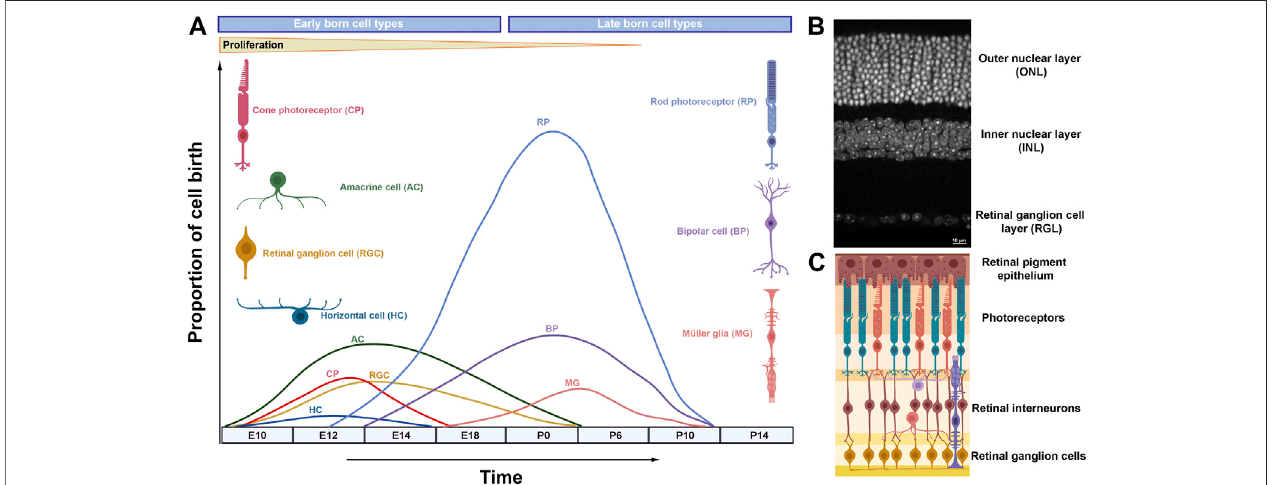
FIGURE 1 | Retinal neurogenesis and organization of the mammalian retina. (A) Schematic diagram illustrating waves of retinal neurogenesis and approximate timing of retinal cell type birth. Note that rod photoreceptors, bipolar cells and Müller glia are mainly formed postnatally. (B) DAPI staining of the adult mouse retina showing its exquisite laminar structure. (C) Retinal laminar position of different cell